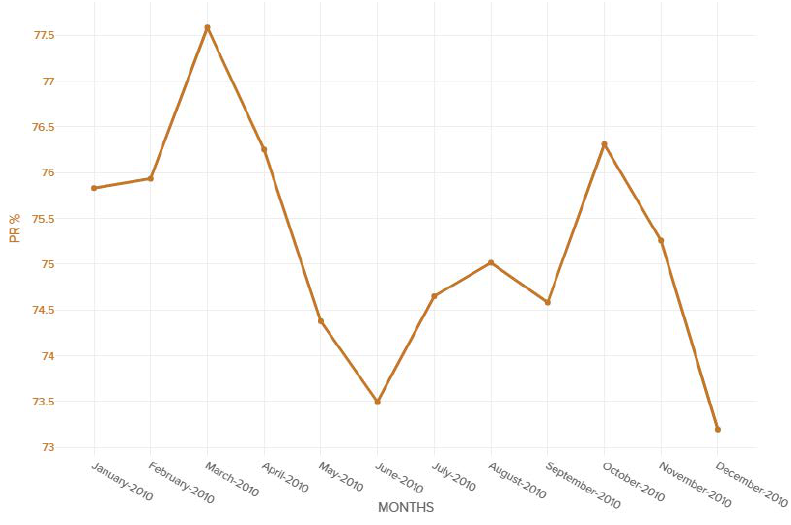
Figure 13. Performance Ratio of the PV plant declines during the target period window leading to a proportional loss of PV production capability during the summer months (April–September).